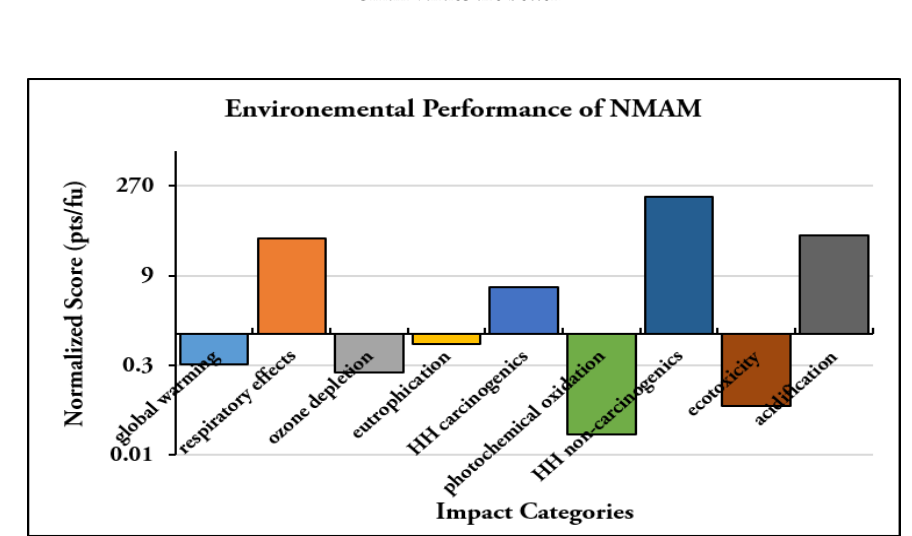
Figure 4. Environmental performance (normalized score) of NMAM. 311